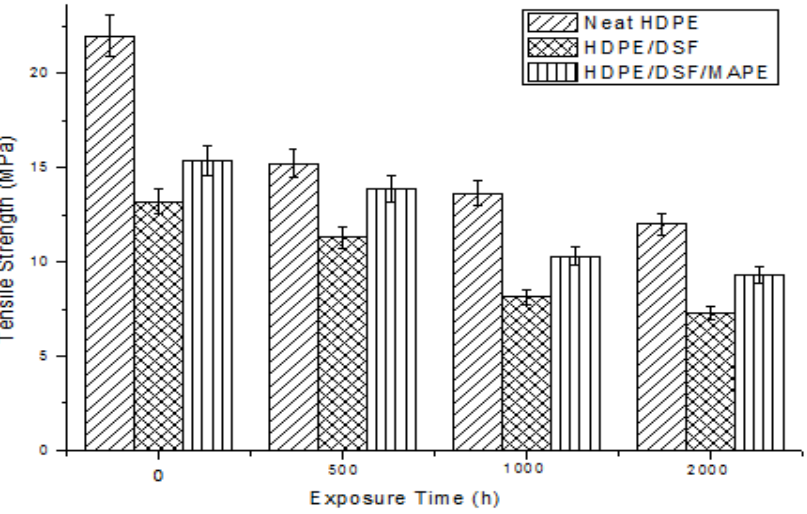
Figure 3: Effect of exposure time of tensile strength of unreinforced HDPE, HDPE/DSF and HDPE/DSF/MAPE